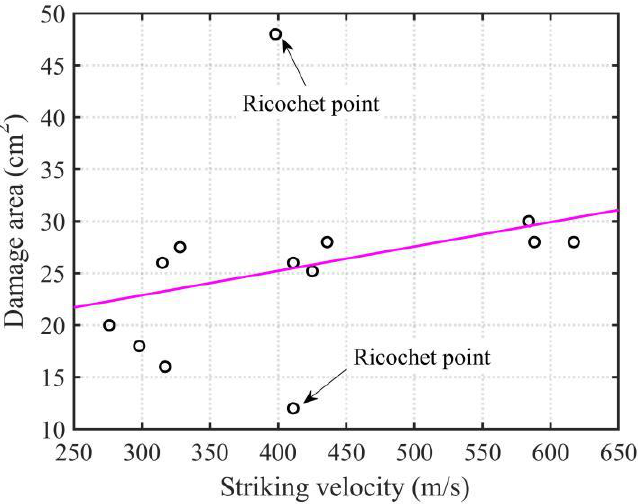
◦ angle of attack.